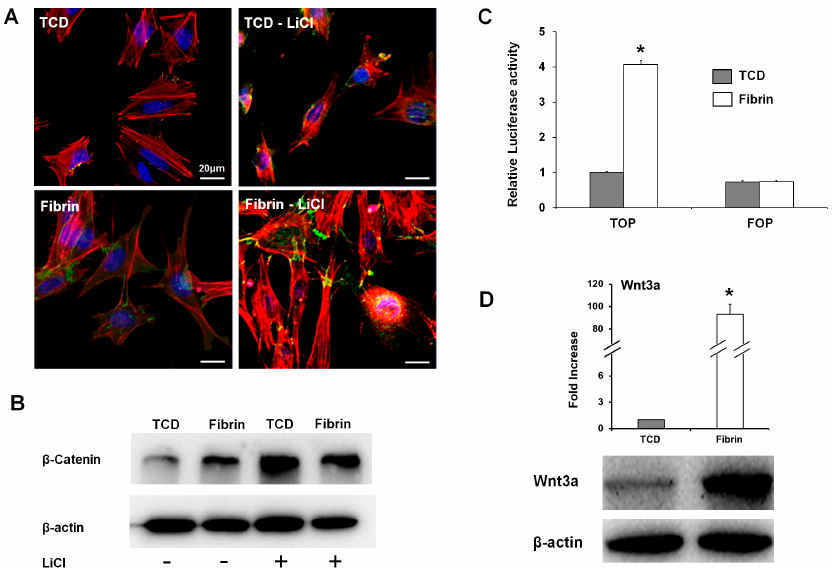
Figure 1. OCCM30 cultured on fibrin enhances canonical Wnt signaling. OCCM30 cells were cultured on fibrin and tissue culture dish (TCD) in differentiation media over a three-day period with/without LiCl. Fibrin induced the translocation of β -catenin from the cytoplasm to the nucleus in cementoblasts (green-fluorescence represented β -catenin): OCCM-30 cells were cultured on fibrin and TCD for three days, and the nuclear translocation of β -catenin detected by immunofluorescence showed that the protein translocated to the nucleus was increased in the cells cultured on fibrin ( A ). β -catenin expression was also determined by immunoblot analysis and it was highly expressed rather than TCD ( B ). Cementoblast cells were transfected with Top flash (wild-type promoter) or Fop flash (mutant promoter) reporter plasmids and cultured in differentiation media for the last 24 h, and luciferase activities were measured in cell lysates and normalized to a Renilla transfection control ( C ). Fibrin exhibited a higher expression of Wnt3a and induced canonical Wnt signaling which was determined by quantitative real-time polymerase chain reaction (PCR) and western blot analysis ( D ). Each experiment was repeated two times independently. * Significantly different ( p < 0.05).